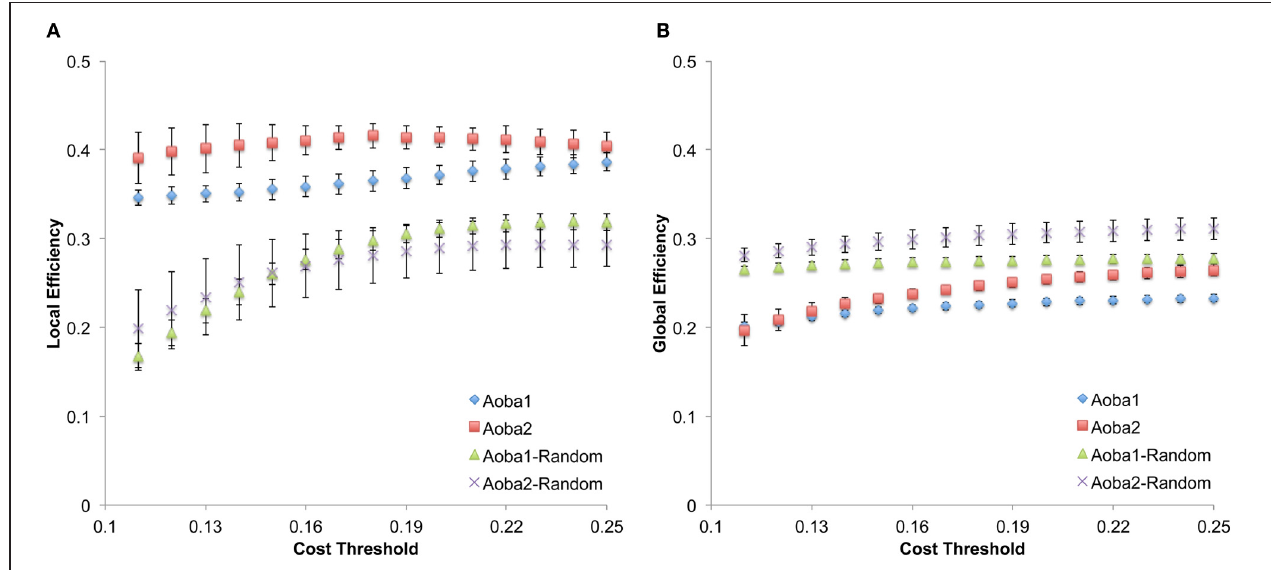
FIGURE 2 | Small-world efficiency properties in structural brain networks. (A) Local efficiency calculated under the cost threshold range of 0.11–0.25. (B) Global efficiency calculated under the cost threshold range of